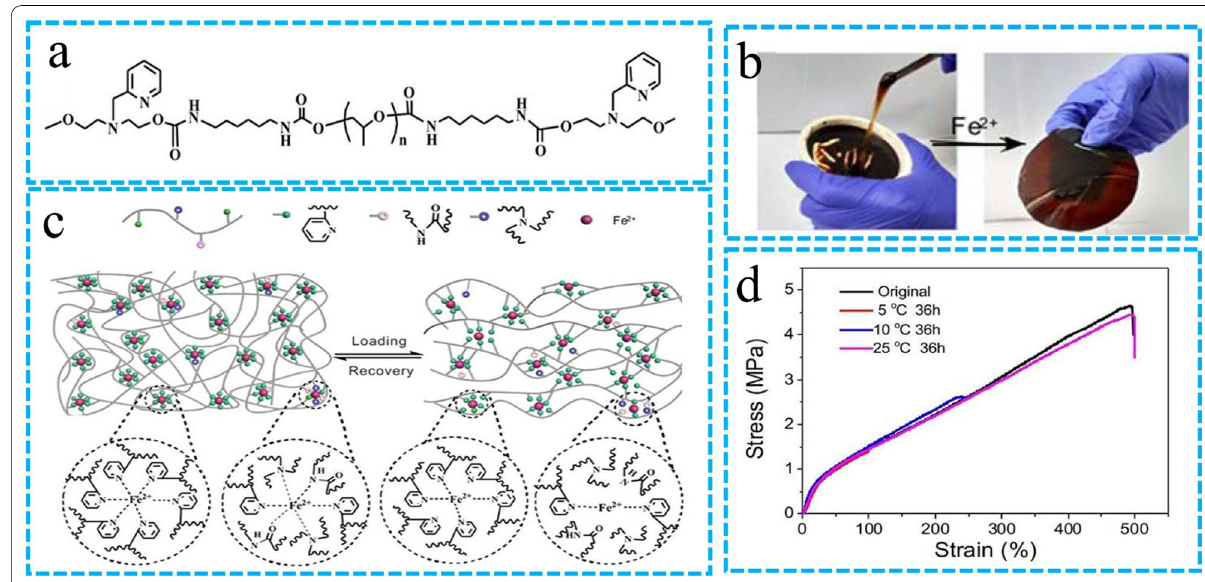
Fig. 10 a Structure of the polyurethane containing containg ligand PY. b Image of Fe 2 + -coordinated PU. c Schematic diagram of fracture and reorganization of strong Fe 2 + -PY and weak Fe 2 + -amide coordination bonds. d Stress–strain curves of the original and repaired samples after healing at different temperatures within 36 h. Reprinted with permission form Reference [75]. Copyright 2019, John Wiley and